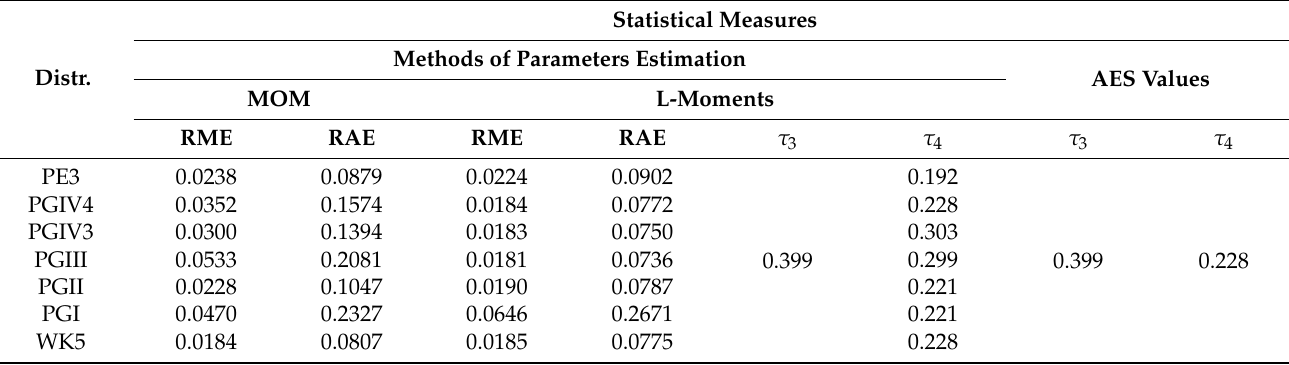
Table 10. Distribution performance values for AMS.